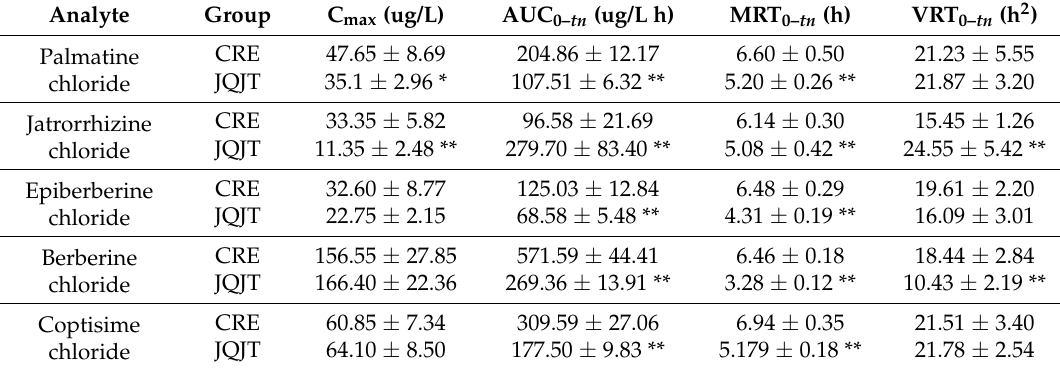
Table 5. The pharmacokinetic parameters of the five alkaloids from JQJT and Coptidis Rhizoma extract (CRE); concentration-time curve (AUC), mean residence time (MTR); variance of residence time (VRT).